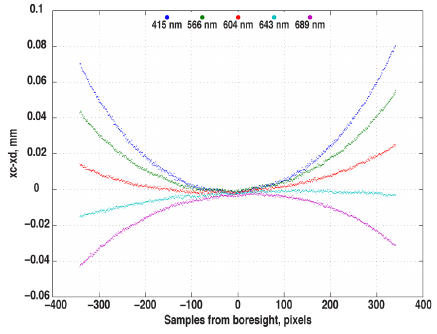
Figure 9. Difference between the corrected (xc) and distorted (xd) pixel location in the down track direction derived from WAC to NAC co-registration. Notice that this method also identified a slight twist in the mounting of the WAC (~0.094°).